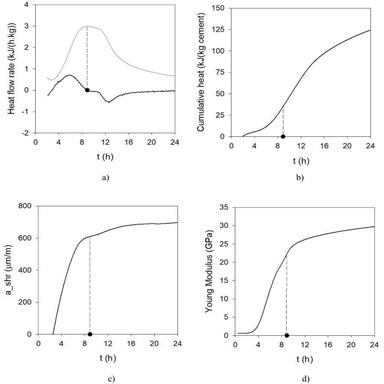
UHPC aging properties evolution up to 24 h of: a) rate of heat flow (grey) and second derivate of cumulative heat (black); b) cumulative heat of hydration; c) autogenous shrinkage; d) MOE.